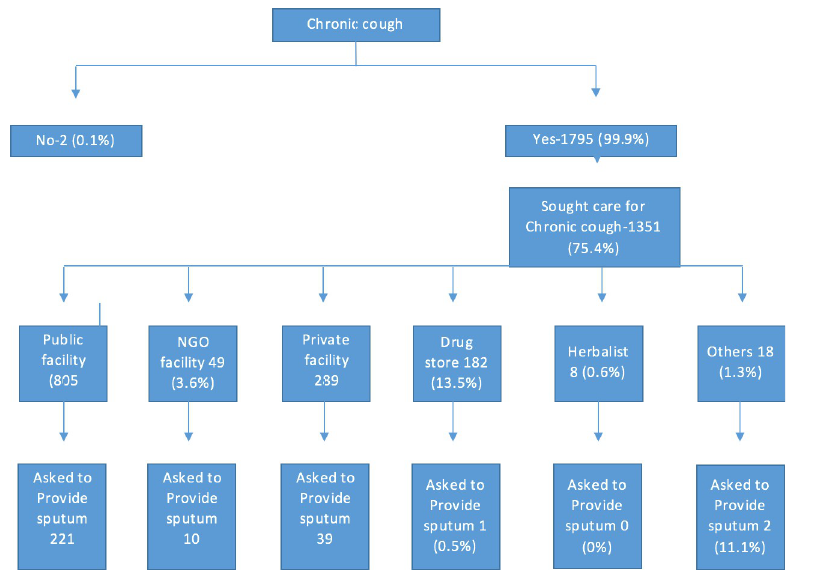
Fig 1. Health Seeking behavior for the presumptive TB patients with chronic cough.